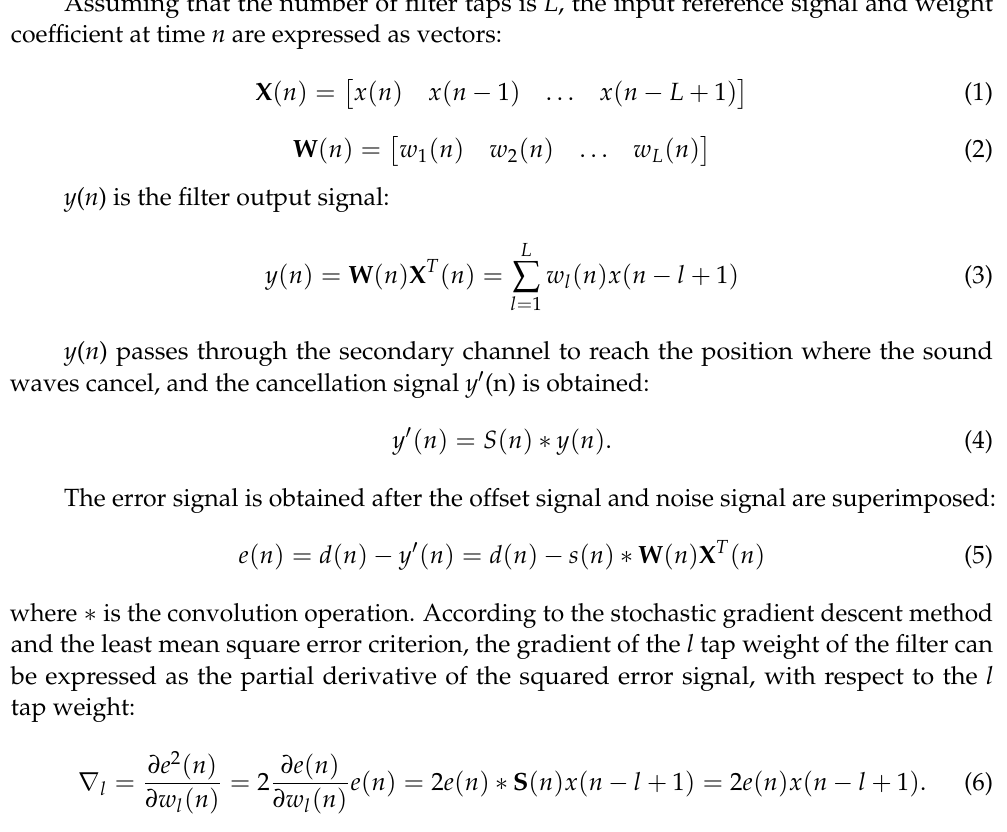
Figure 2. Schematic diagram of the feed-forward FxLMS algorithm.